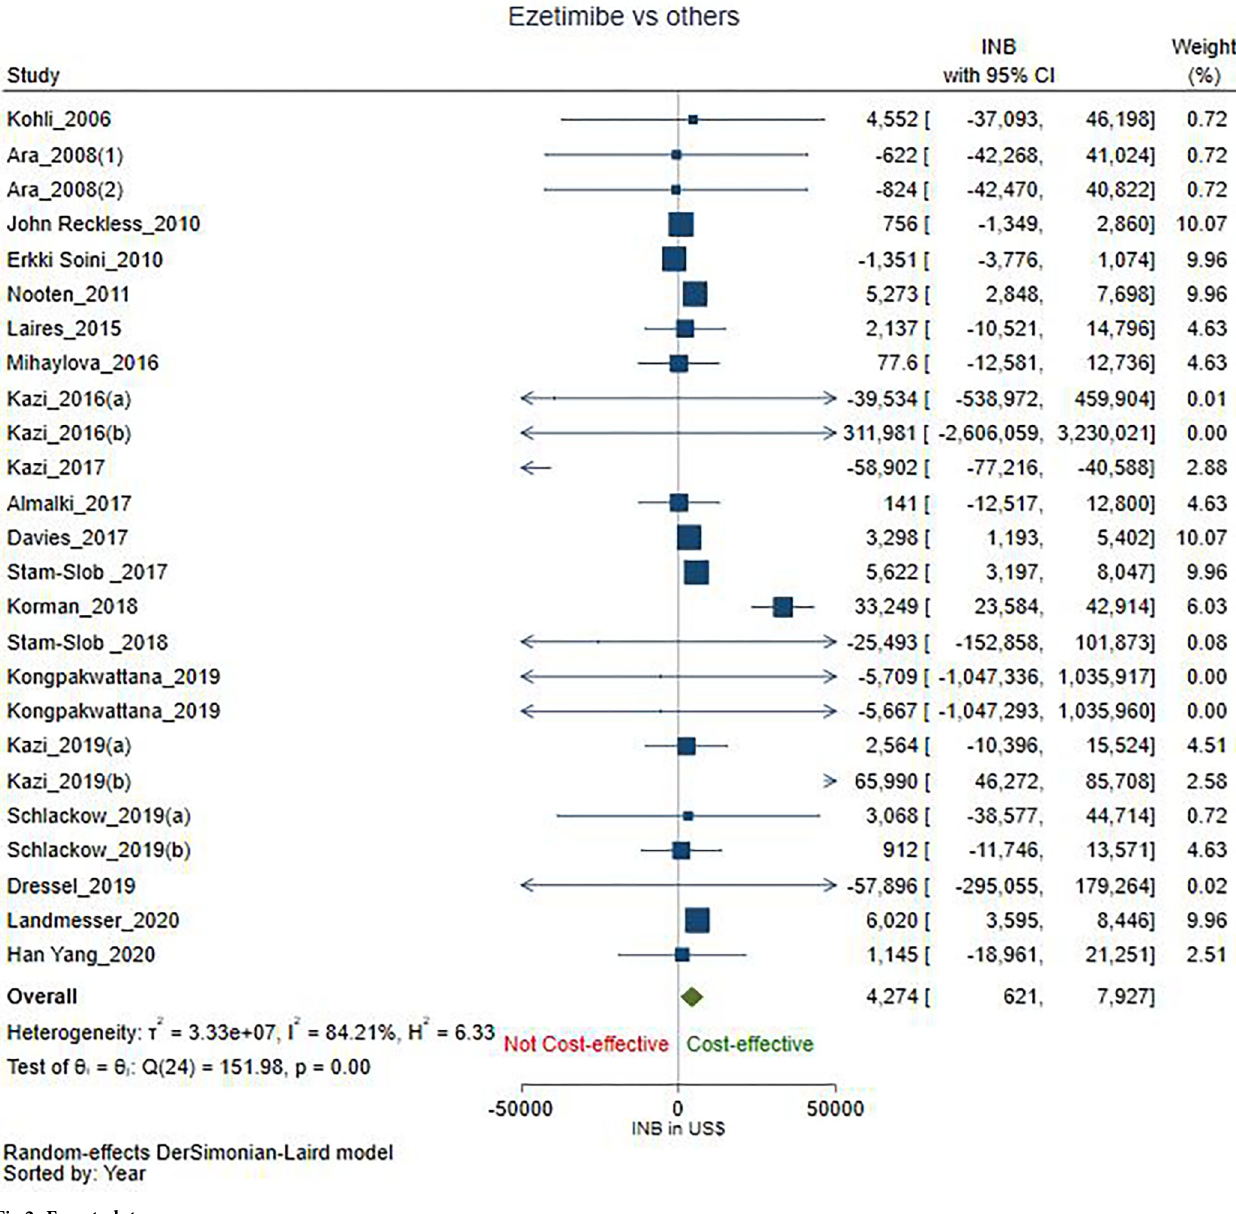
Fig 2. Forest plot.